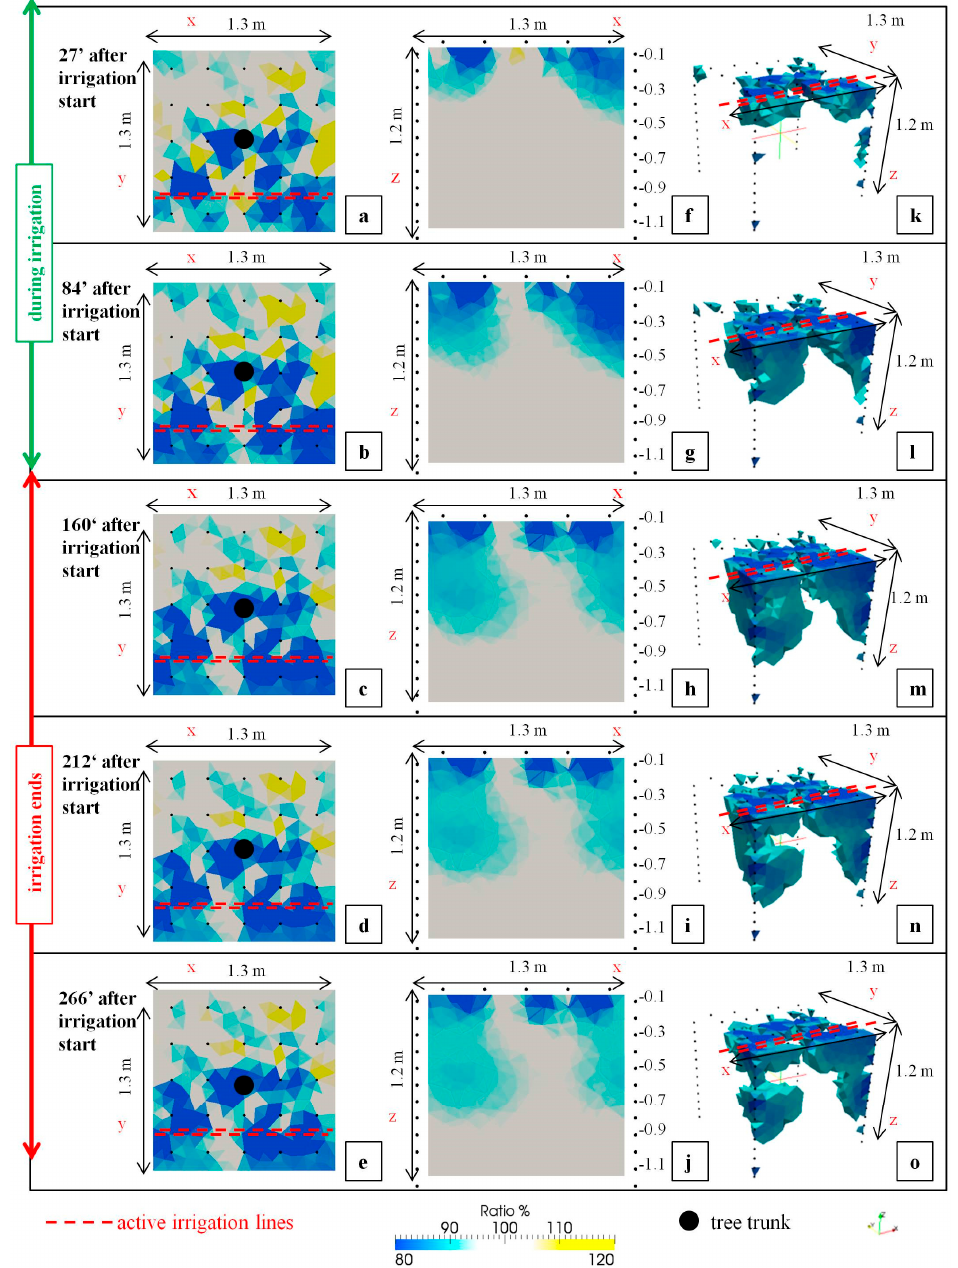
Figure 5. Time-lapse electrical resistivity (ER) ratio imagery (at the surface: a – e ; transects under the Figure 5. Time ‐ lapse electrical resistivity (ER) ratio imagery (at the surface: a ‒ e ; transects under the irrigation pipeline: f – j ; and 3-D volumes: k – o ) for T1 with respect to the initial condition (no irrigation pipeline: f ‒ j ; and 3 ‐ D volumes: k ‒ o ) for T1 with respect to the initial condition (no irrigation).